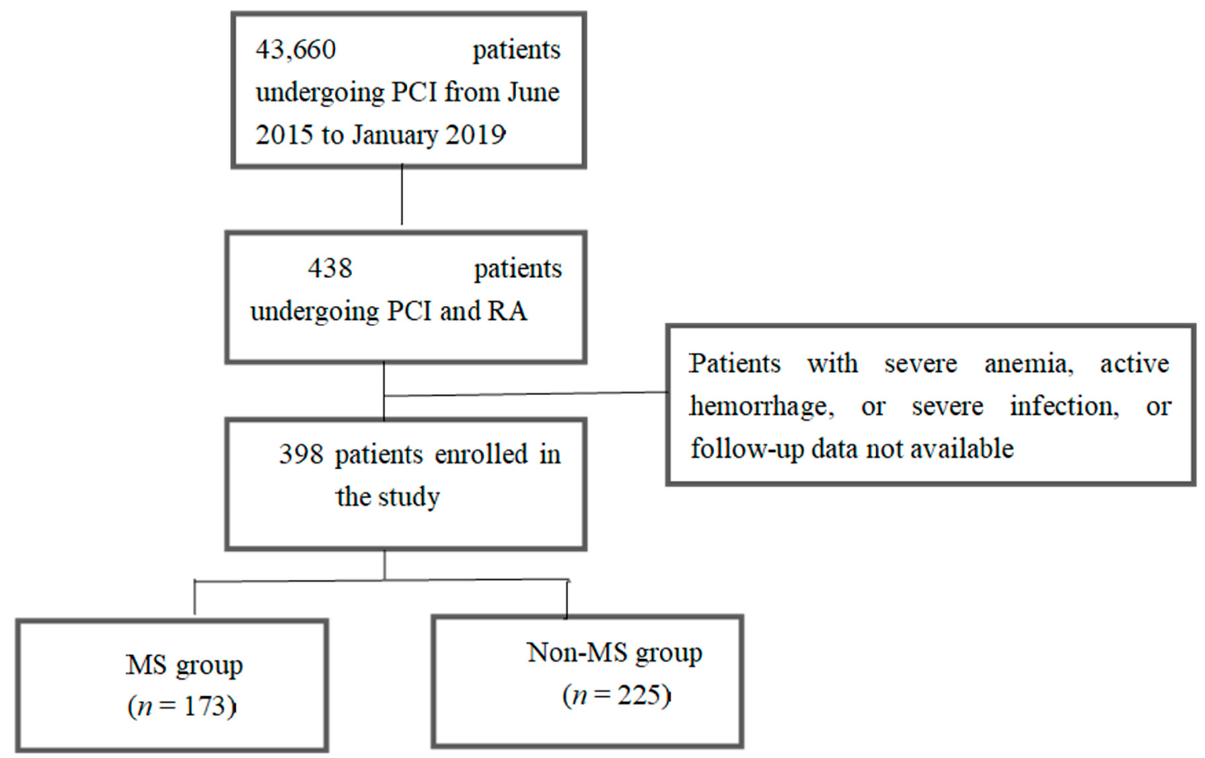
Figure 1. Study flow chart. 43,660 patients undergoing percutaneous coronary intervention (PCI) and 398 patients treated with treated with drug-eluting stenting after rotational atherectomy for complex calcified coronary lesions were consecutively enrolled between June 2015 and January 2019.